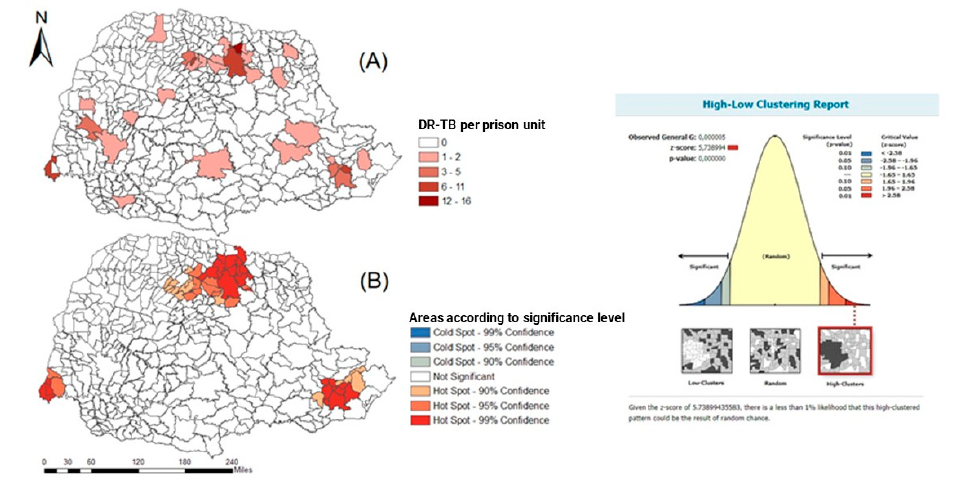
Figure 4. Spatial distribution of DR-TB cases in the liberty-deprived population in the state of Paraná, Brazil, 2008 to 2018. ( A ) DR-TB in the iberty-deprived population is present in all regions of the state, with a greater number of cases in clusters in the northern region. ( B ) hotspots in the north, east, and west of the state, with a statistical significance level above 90% confidence.